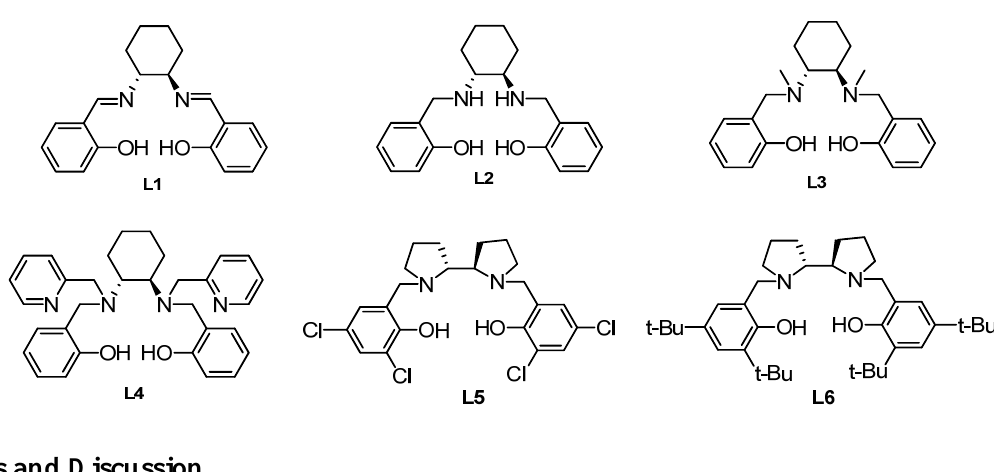
Figure 1. Structures of Ligands